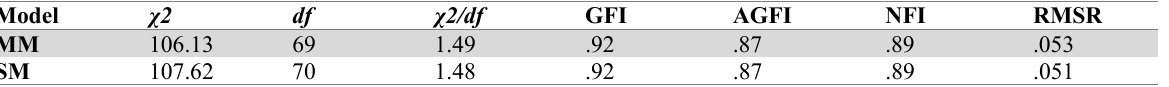
Goodness-of-Fit Indices for Measurement and Structural Models Model χ 2